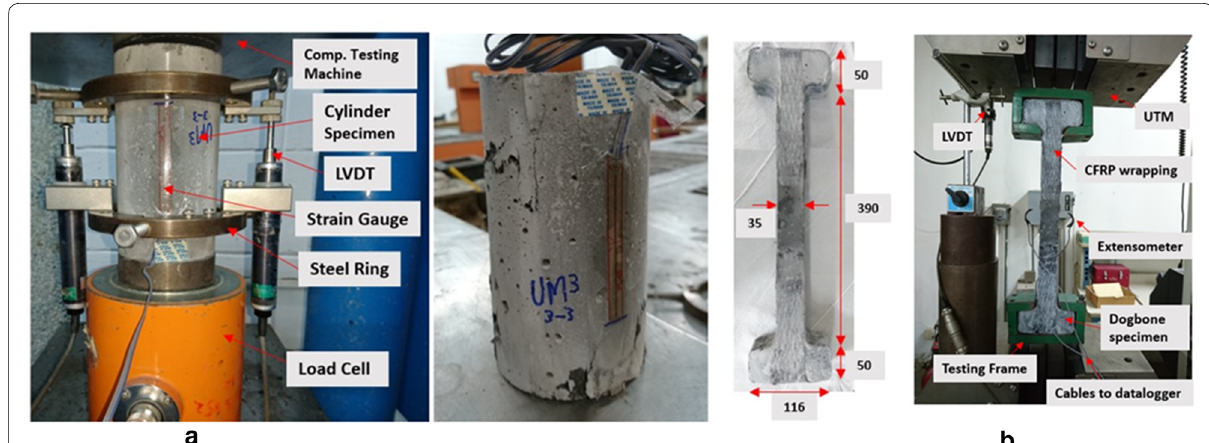
Fig. 2 Test setup a uniaxial compressive test on cylindrical specimen of UHPC, b uniaxial direct tensile test of UHPC dogbone specimen (all dimensions in mm).